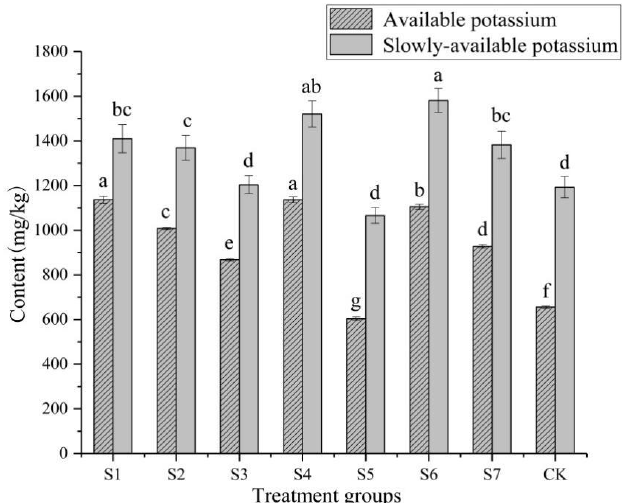
Figure 3. Effects of potassium-solubilizing bacteria on available potassium and slow-available po- tassium in rhizosphere soil of Paris polyphylla var. yunnanensis. a-g:Different letters indicate signifi- potassium in rhizosphere soil of Paris polyphylla var. yunnanensis . a–g: Different letters indicate cant difference between each other ( p < 0.05). significant difference between each other ( p <